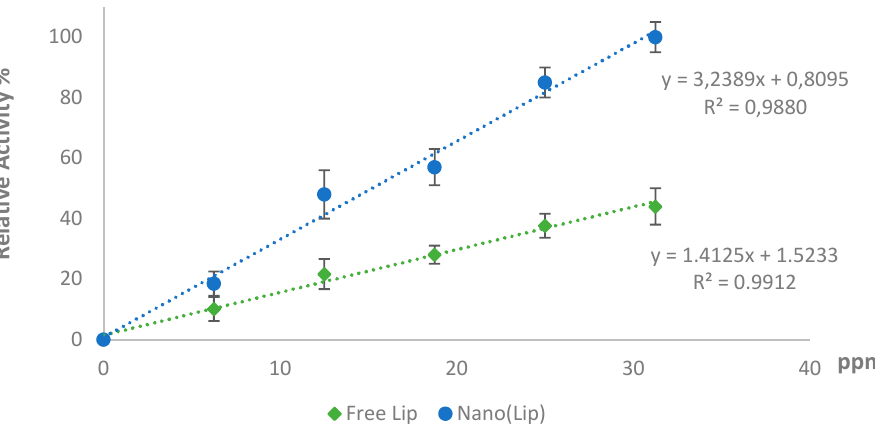
Figure 8. Linearity of free LiP and Nano-LiP.